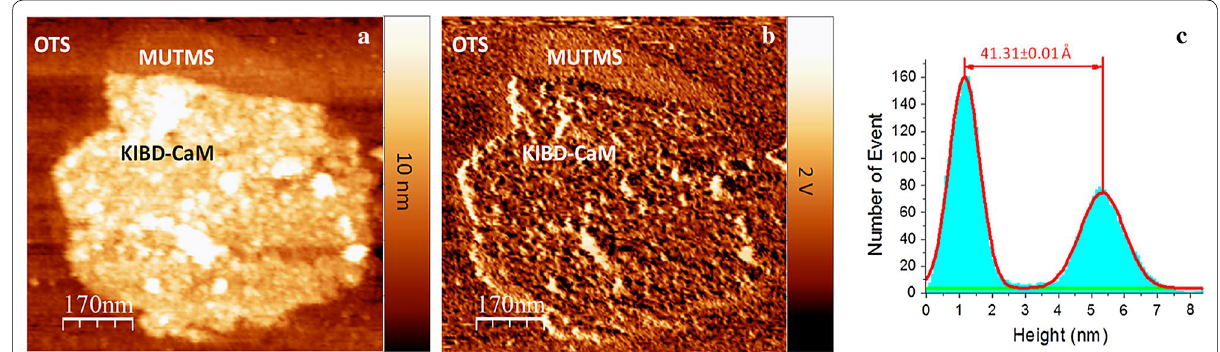
Fig. 5 Sample in Fig. 4 was incubated in CaM KI binding domain solution for 10 min. a AFM ac mode topography image. b Corresponding phase image. c Histogram corresponding to protein fully covered area in ( a ). The distance between the two peaks in the histogram specifies the height of the KIBD-CaM pattern over OTS background in ( a